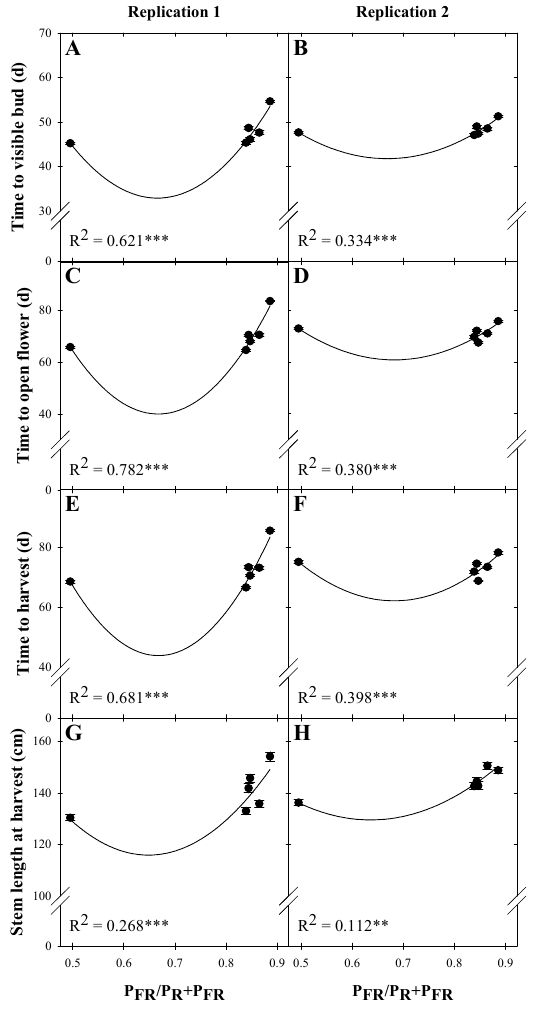
Figure 5. Influence of estimated phytochrome photoequilibrium (PFR/PR+PFR) of supplemental lighting treatments on ( A , B ) time to visible bud, ( C , D ) time to open flower, ( E , F ) time to harvest, and ( G , H ) stem length at harvest of snapdragon ‘Potomac Royal’ during replications 1 and 2. Black symbols represent means; error bars represent standard error. R 2 values are presented; ** and *** indicate model significance at p < 0.001 and p < 0.0001, respectively. Coefficients are presented in Table 5.